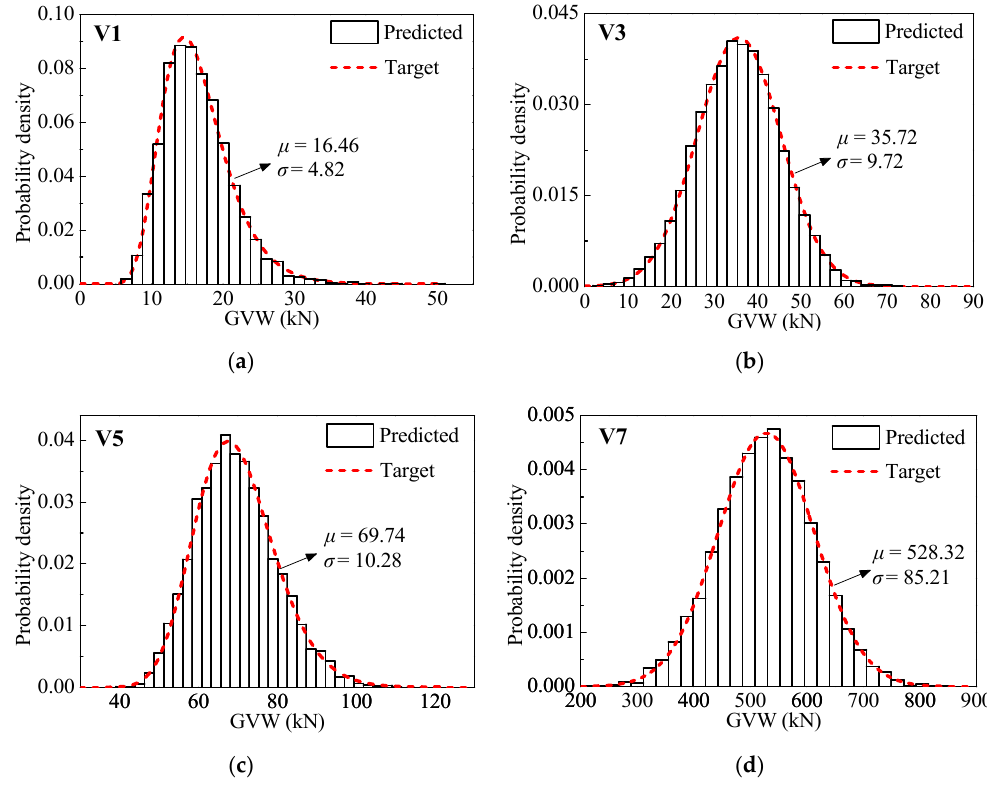
Figure 5. Comparison between the predicted distribution of the gross vehicle weight of various vehicle types in the simulated stochastic traffic flow and the target distribution ( a ) V1, ( b ) V3, ( c ) V5, and ( d ) V7.